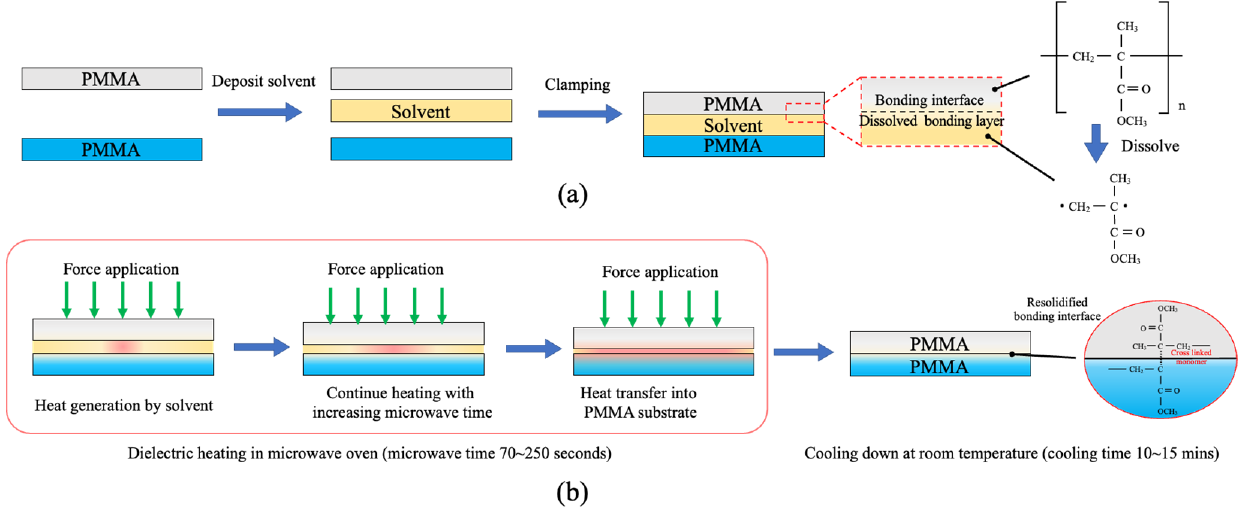
Figure 4. Schematic illustration of microwave-assisted solvent bonding by ( a ) solvent activation and b ) microwave irradiation ( b ) microwave irradiation mechanism. (